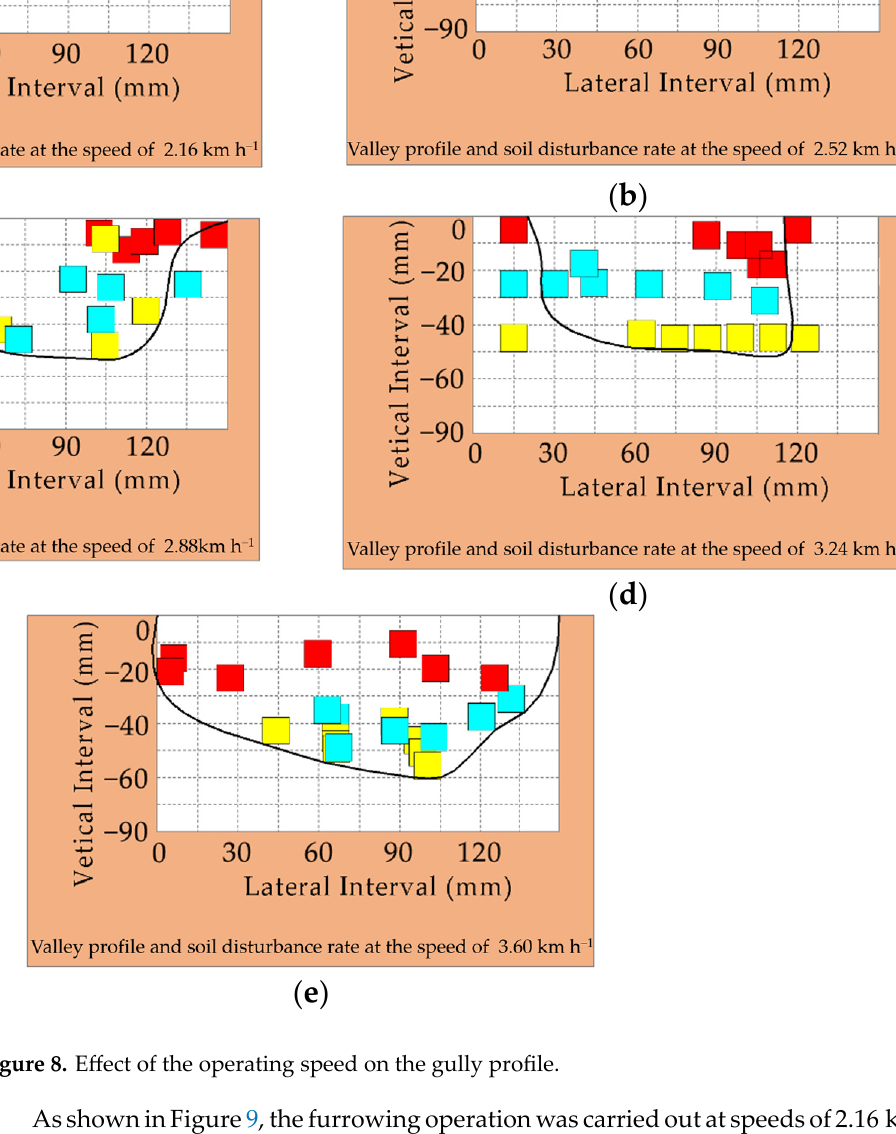
increase in speed. The disturbance rate of the furrow opener to the soil increases with the increase in speed when the speed is between 2.88 km h